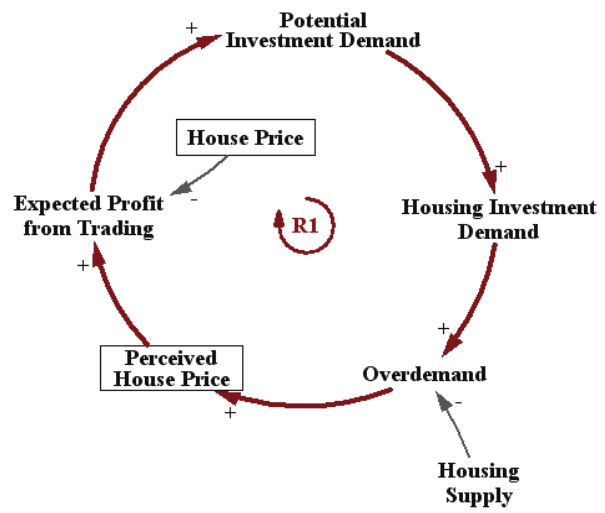
figure 3. Housing investment demand and expectancy of house price